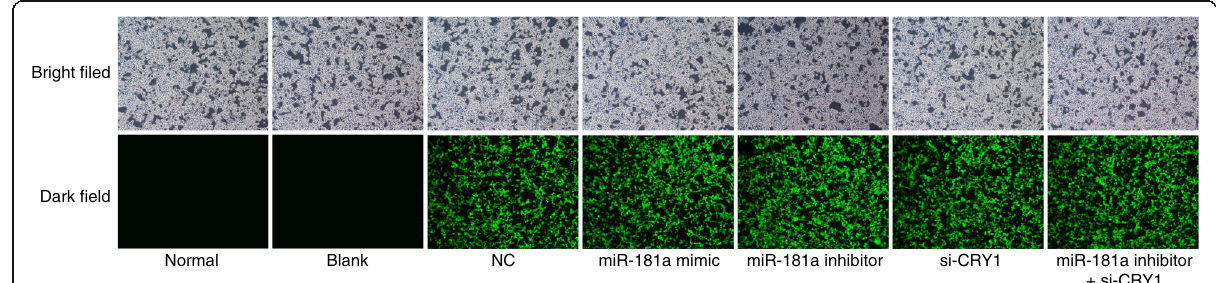
Fig. 1 Fluorescence microscopy image of kidney tissue in rats (× 400) reveals that the plasmid in each group was successfully transfected. Notes: The images were photographed in the bright field (natural light) and dark field (without natural light). miR-181a, microRNA-181a; CRY1, cryptochrome 1; CKD, chronic kidney disease; NC, negative control